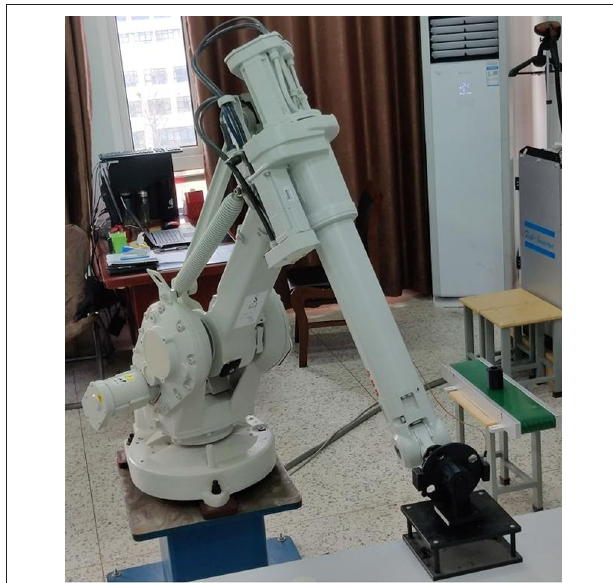
FIGURE 17 | Working position diagram of experimental assembly